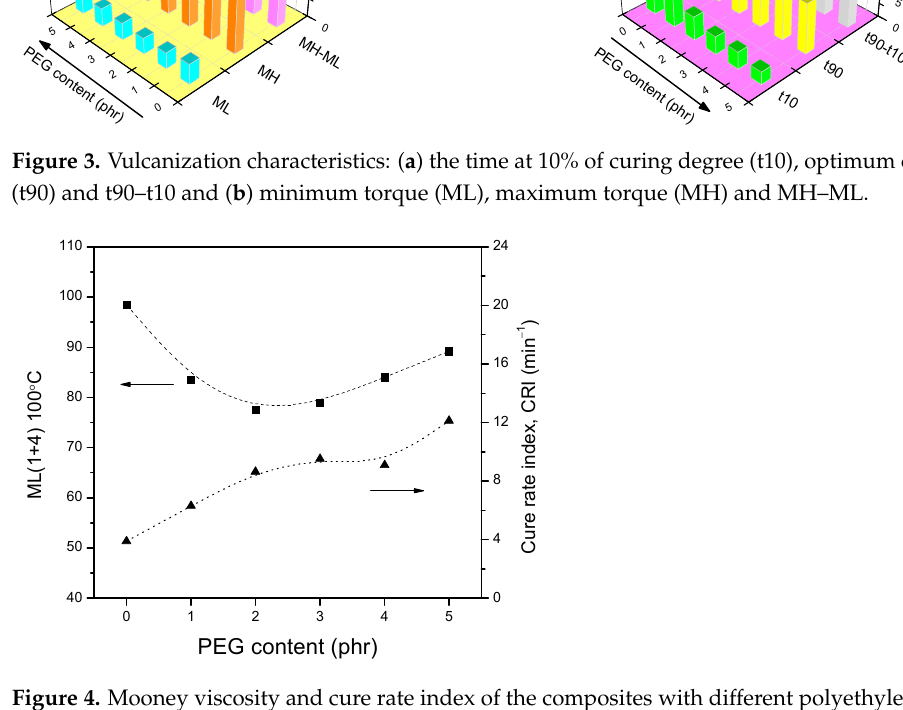
Figure 4. Mooney viscosity and cure rate index of the composites with different polyethylene gly- col (PEG) contents. (PEG)